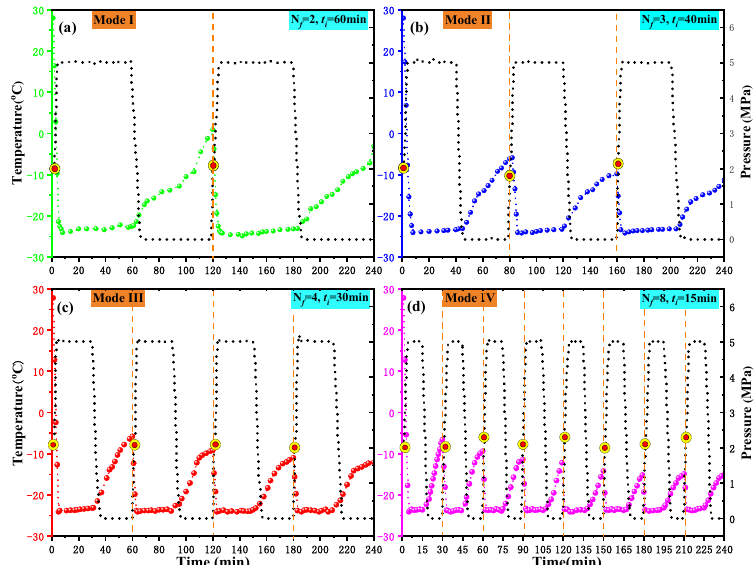
Figure 5. Variation in the temperature and pressure of the freeze–thaw container. ( a ) Model I. ( b ) Model II. ( c ) Model III. ( d ) Model IV. (Note: N c represents Number of Cycle, and P c represents Period of Cycle).